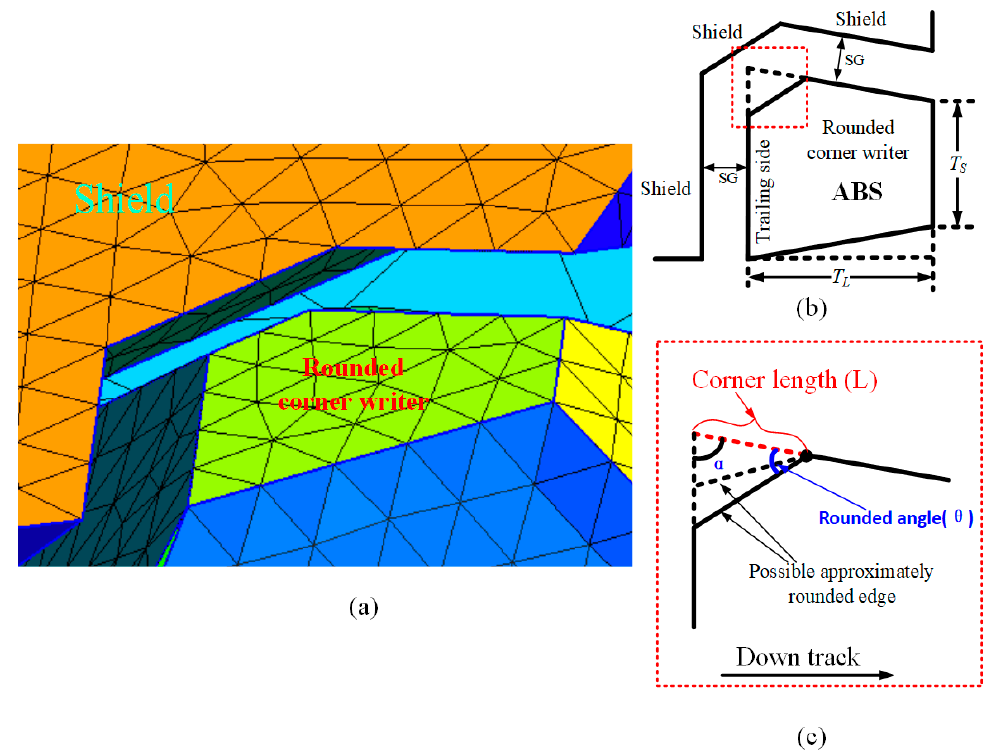
Figure 1. ( a ) 3-D Model of shingled rounded corner writer; ( b ) Pole tip from ABS view. The main pole is half-wrapped around by shield; ( c ) Illustration of the rounded corner writer. The writer is characterized by write corner angle ( α ), rounded angle ( θ ), and corner length ( L ).